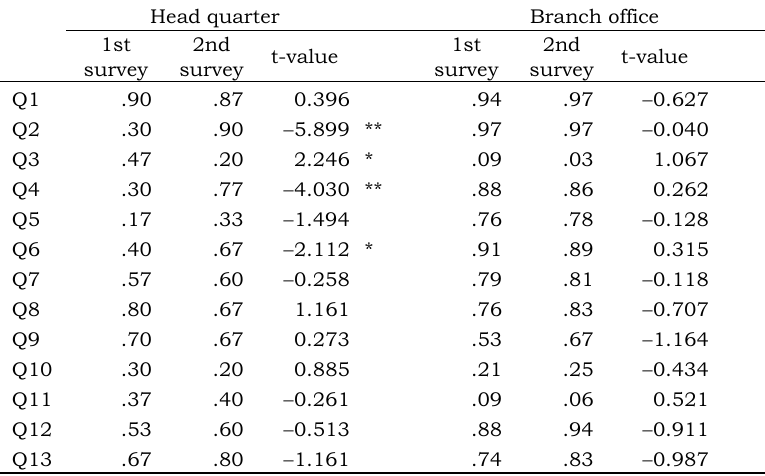
Table 2. Comparison between the first and the second surveys Head